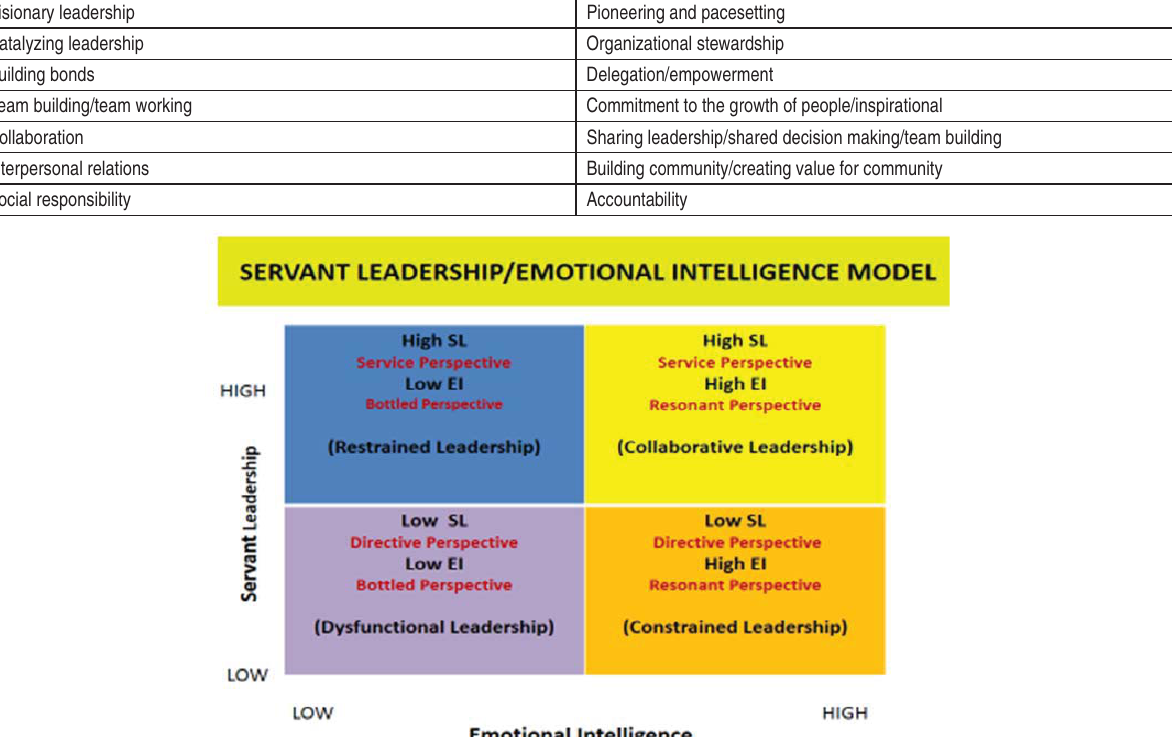
Fig. 2. Integrated SL/EI-lead impact